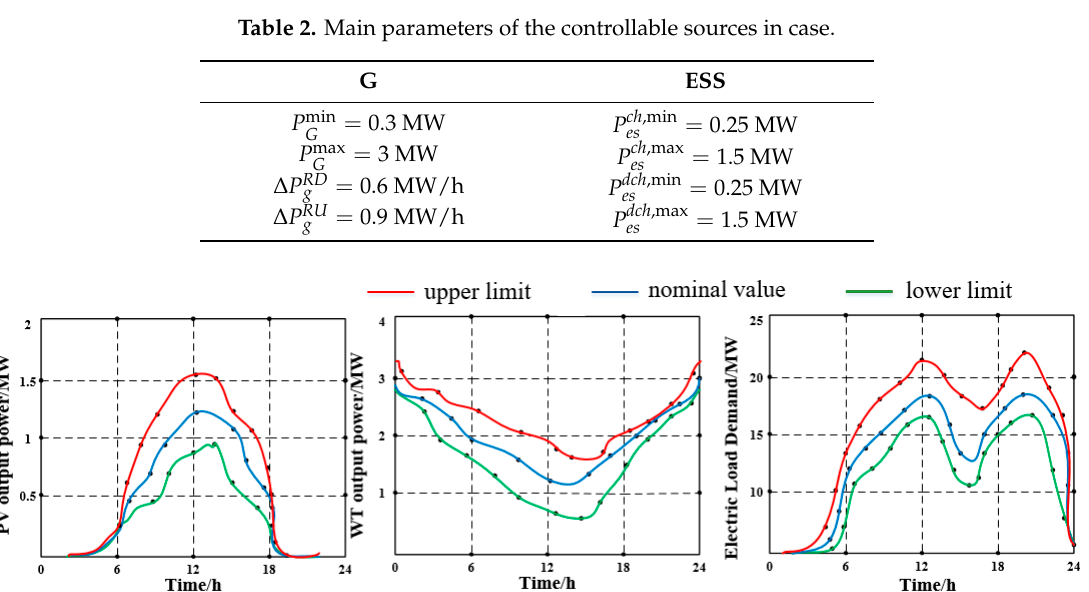
Table 2. Main parameters of the controllable sources in case.